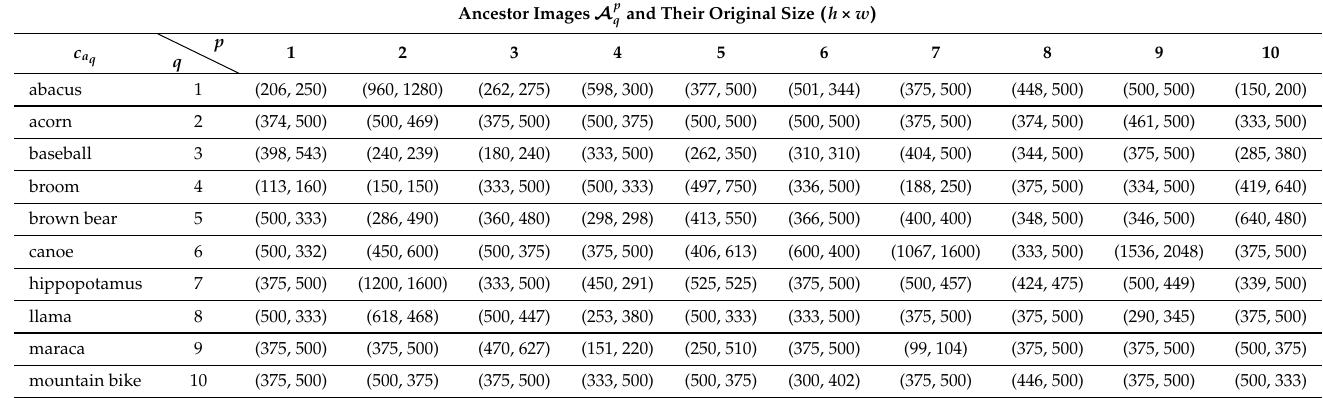
Table A1. The original sizes ( h × w ) of the 100 ancestor images A p q before resizing with the bilinear interpolation function.